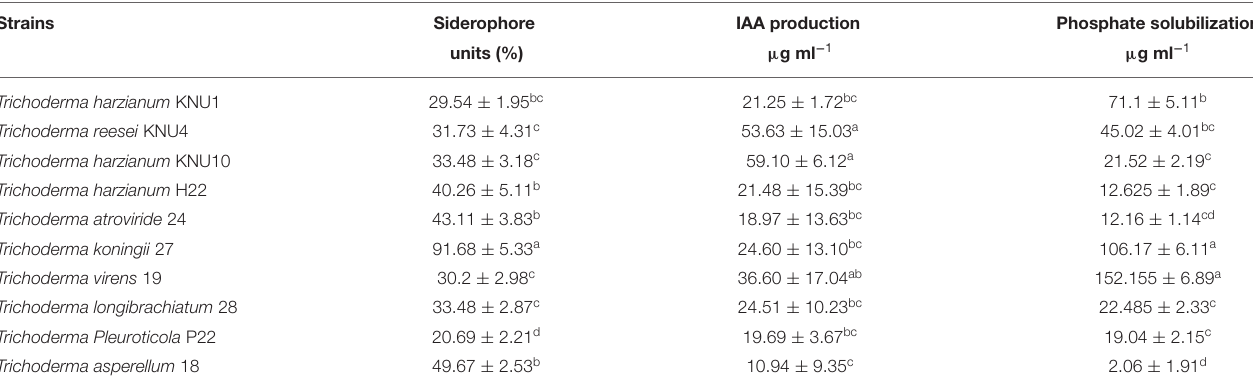
TABLE 2 | Plant growth-promoting activities of the selected rhizosphere Trichoderma sp. strains. Strains